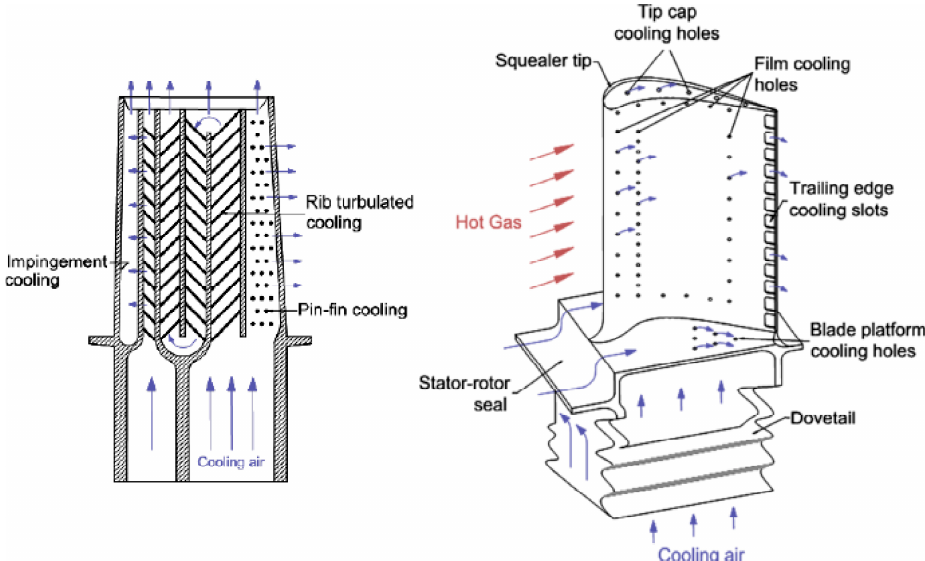
Figure 3. Typical cooling system for modern gas turbine blades. Adapted with permission from